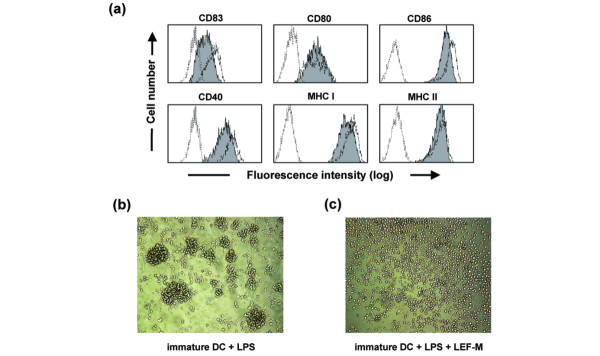
Treatment with LEF-M during maturation of immature DCs leads to a differentially affected phenotype. Monocytes were cultured for 5 days with granulocyte–macrophage colony-stimulating factor (GM-CSF; 50 ng/ml) plus IL-4 (10 ng/ml). (a) On day 5 these immature dendritic cells (DCs; 5 × 105/ml) were activated with lipopolysaccharide (LPS; 100 ng/ml) in the absence or presence of 150 μmol/l of the active metabolite of leflunomide (LEF-M) for 48 hours. Surface marker expression was determined by fluorescence-activated cell sorting analysis. Open profiles with dotted line represent the staining pattern with an isotype control, open profiles with fine line indicate the staining pattern of DC exposed to LPS with the indicated monoclonal antibodies, and solid grey profiles show staining of DCs matured in the presence of LEF-M. The results shown are representative of five independent experiments. (b,c) Effect of LEF-M on maturation-associated clustering of DCs; immature DCs were stimulated with LPS in the (panel b) absence or (panel c) presence of 150 μmol/l LEF-M. After 8 hours of cultivation, cells were analyzed by inspecting photomicrographs obtained by light microscopy. Similar results were obtained in four additional experiments. MHC, major histocompatibility complex.